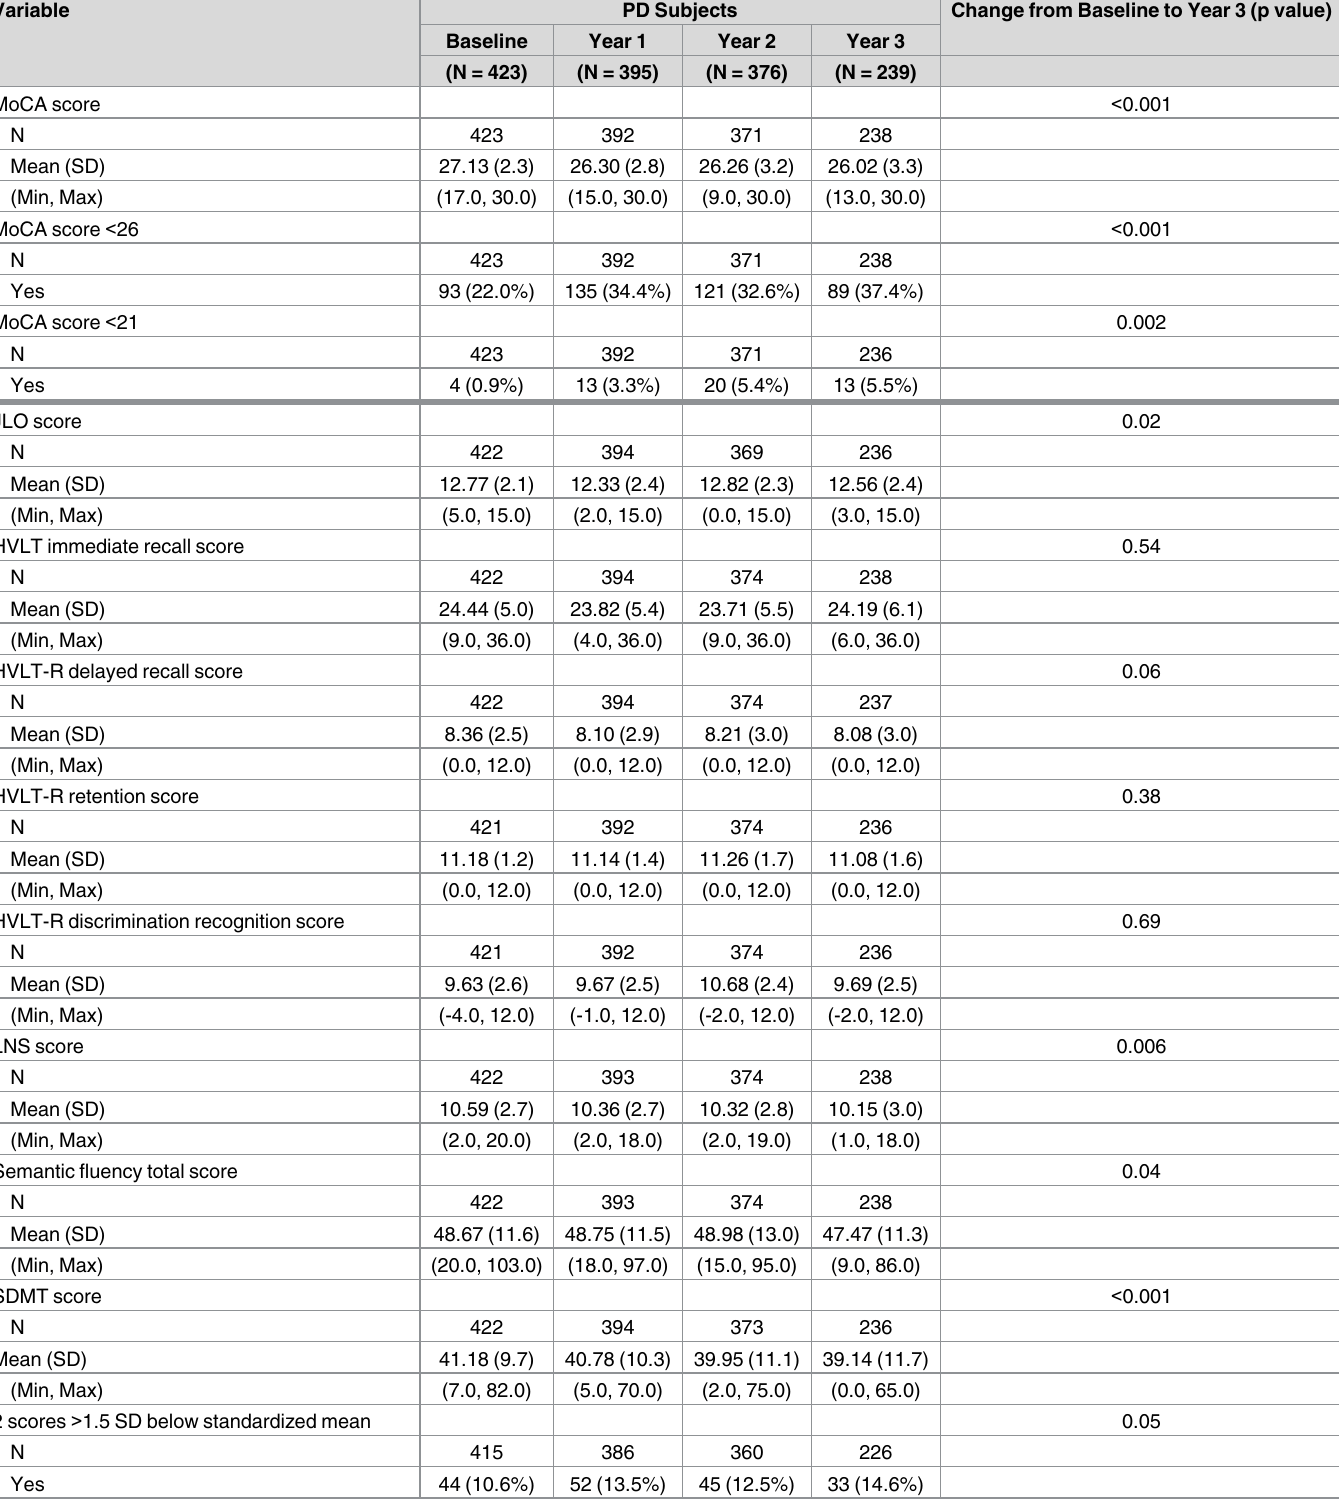
Table 3. Cognitive outcomes over